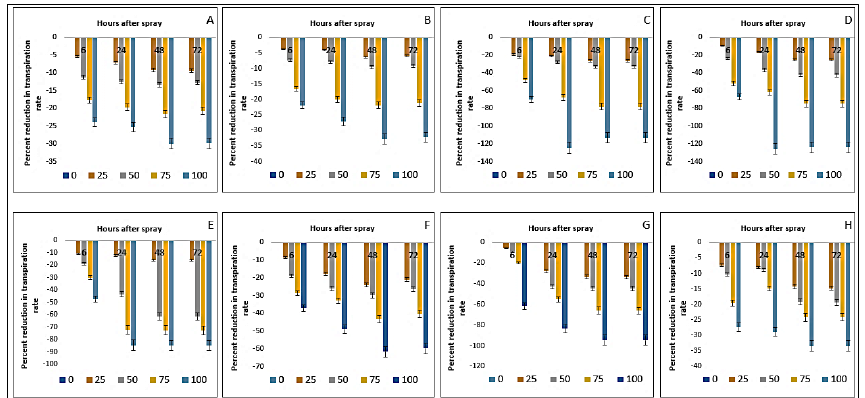
Figure 11. Reduction (%) of transpiration rate of several crops and weeds due to the eefect of parthenium leaf methanol extract: ( A )—Bambara groundnut; ( B )—Maize; ( C )— D. sanguinalis ; ( D )— E. indica ; ( E )— A. conyzoides ; ( F )— C. iria ; ( G )— E. hirta , and ( H )— C. difformis .